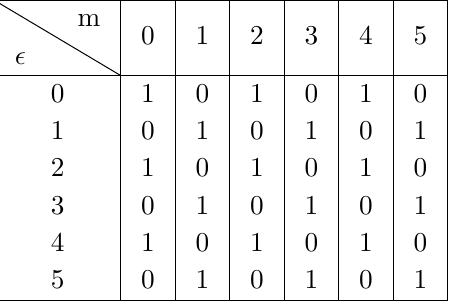
Table 4 . Counting states with any number of m and (cid:15)